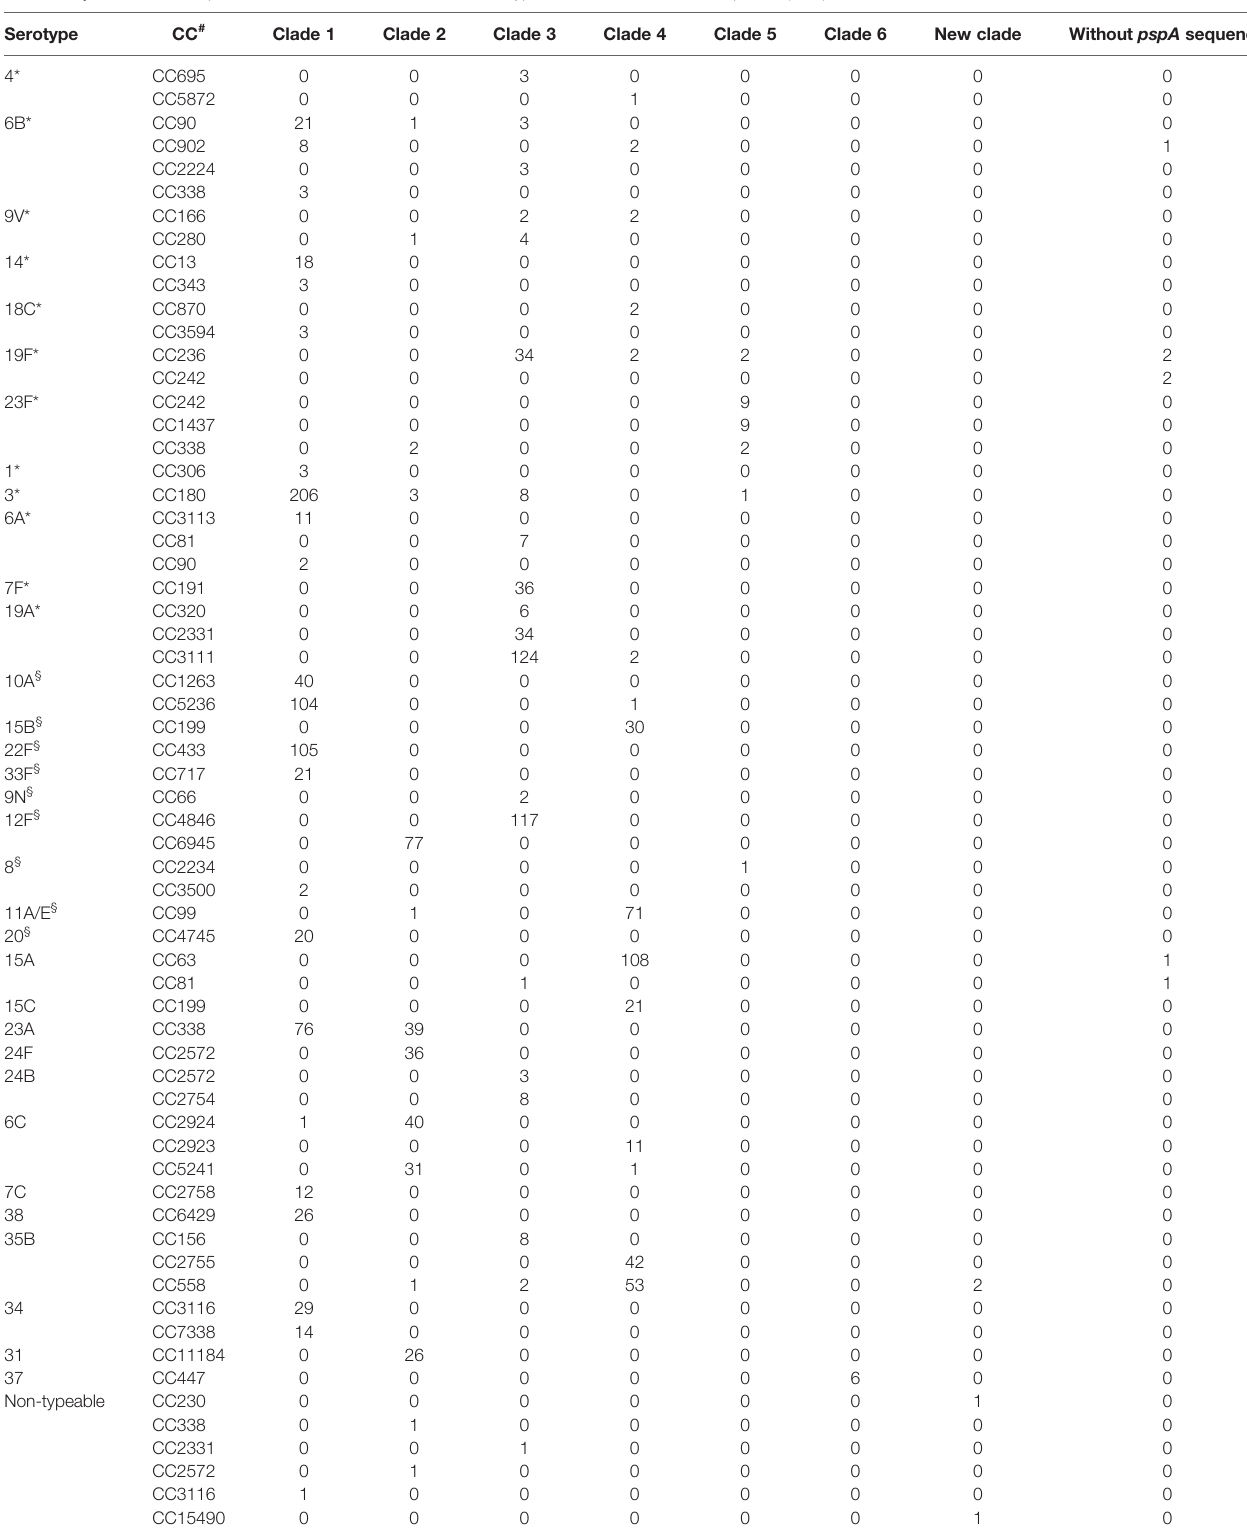
TABLE 1 | Number of the pneumococcal strains with different serotypes and different clonal complexes (CCs).